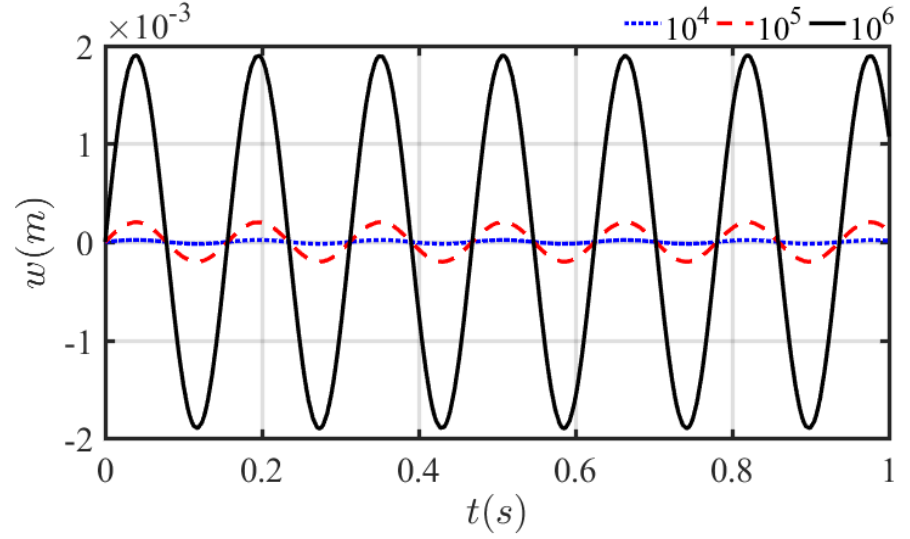
t on pipes conveying fluid nonlinear transient vibration. p